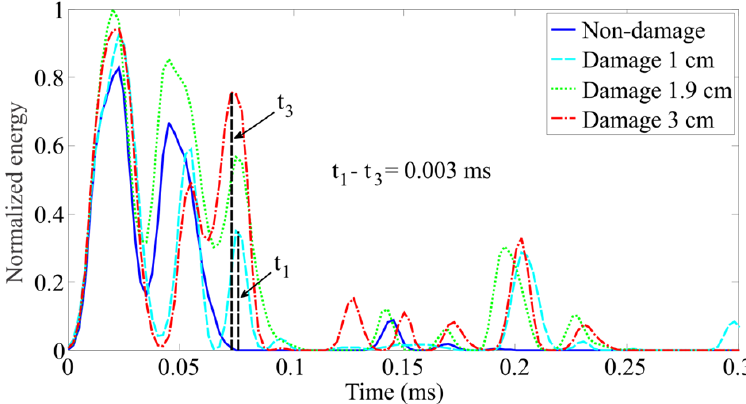
Figure 11. Energy time spectrum for the phase shifts of progressive damage